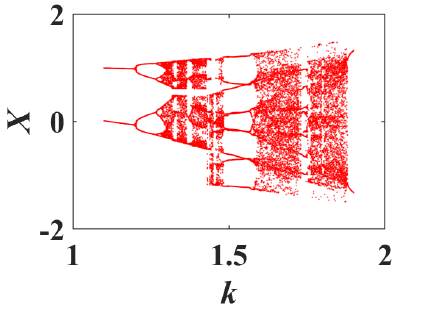
Figure 5. Bifurcation diagrams with q = 0.98, k ∈ ( 1,2 ) .